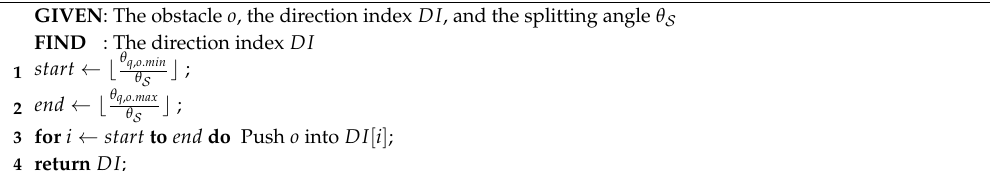
Algorithm 7. Insert an obstacle into a direction index (InsertToDI) algorithm.